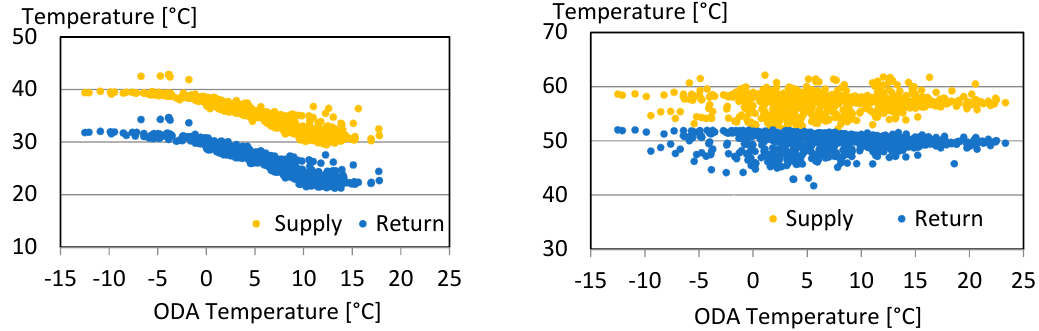
Figure 9. Measured daily average supply and return temperatures for space heating ( left ) and hot water ( right ) plotted against outdoor air temperatures.